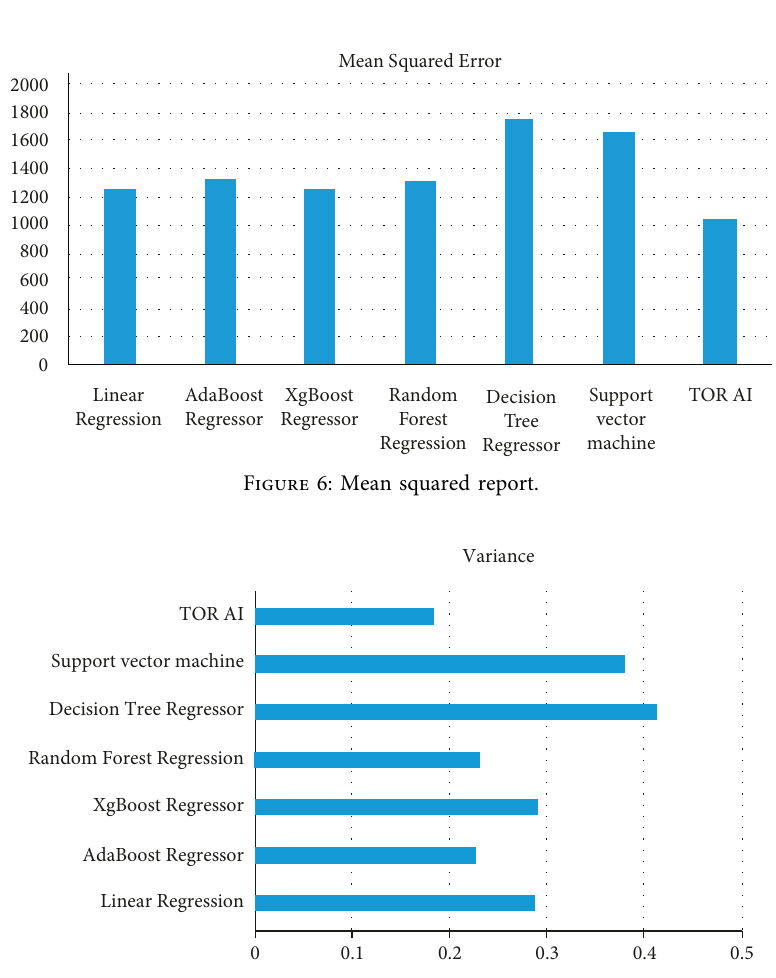
Figure 7: Variance